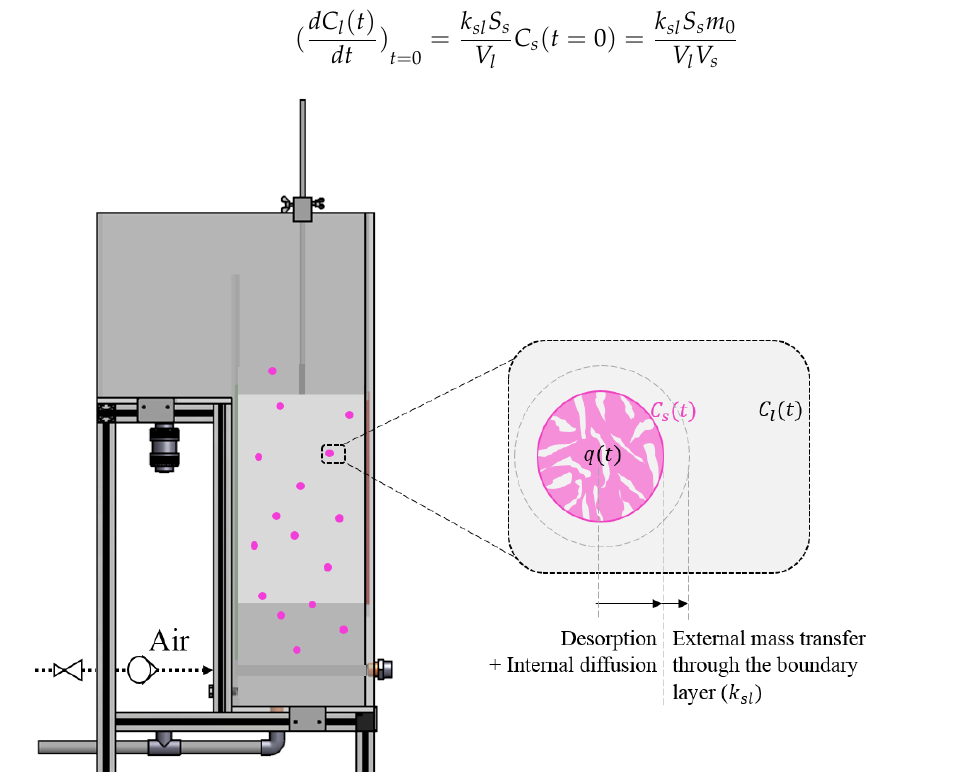
Figure 6. Illustrative representation of the transfer of Rose Bengal lactone from the solid medium to the liquid, in the aerobic tank of the lab-scale MBR.